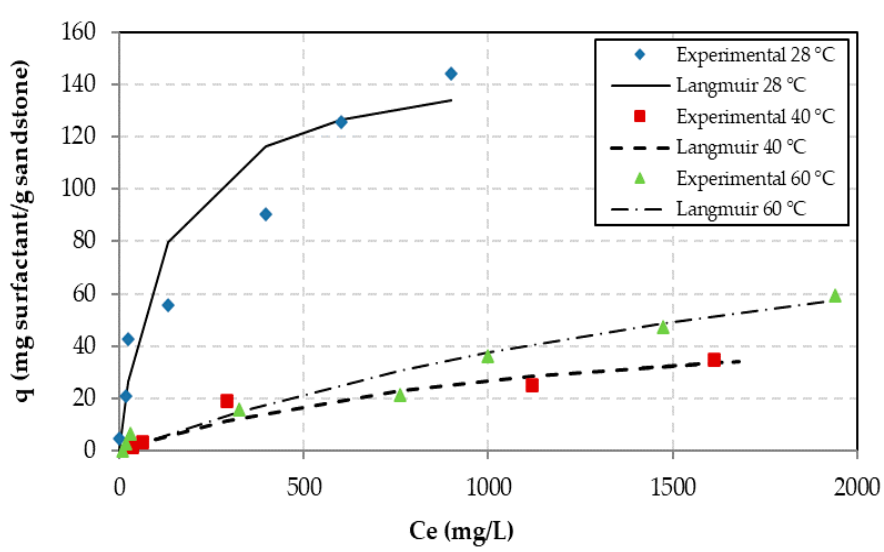
Figure 3. SCO/glycerol adsorption isotherm.